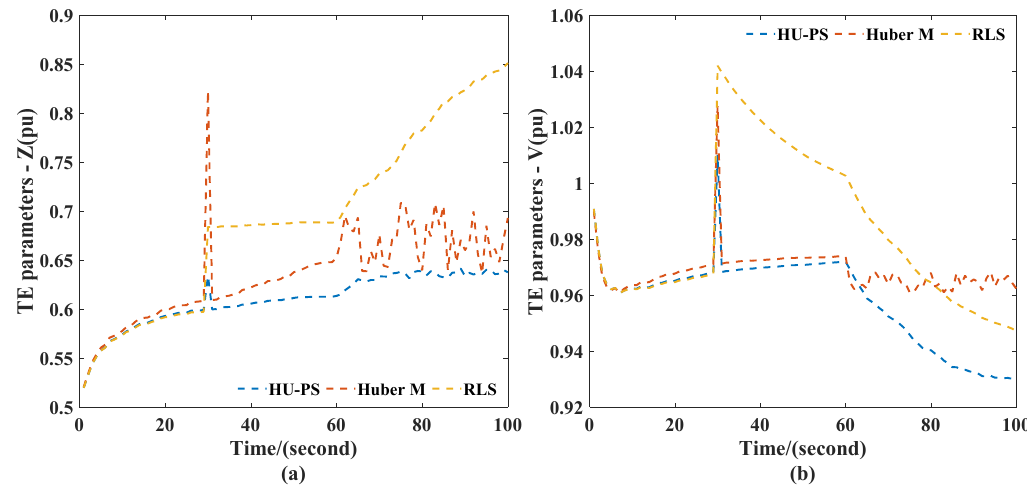
Figure 11. TEPs obtained in case II scenario 2: ( a ) impedance, ( b ) voltage.